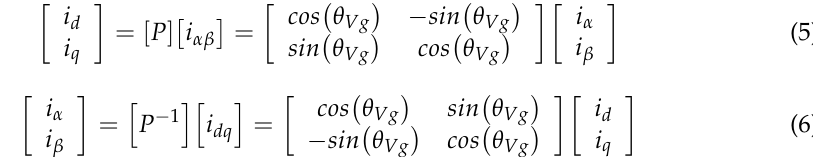
Figure 5. Space vector diagram of the stationary abc / αβ reference frames and the rotating dq coordinates.